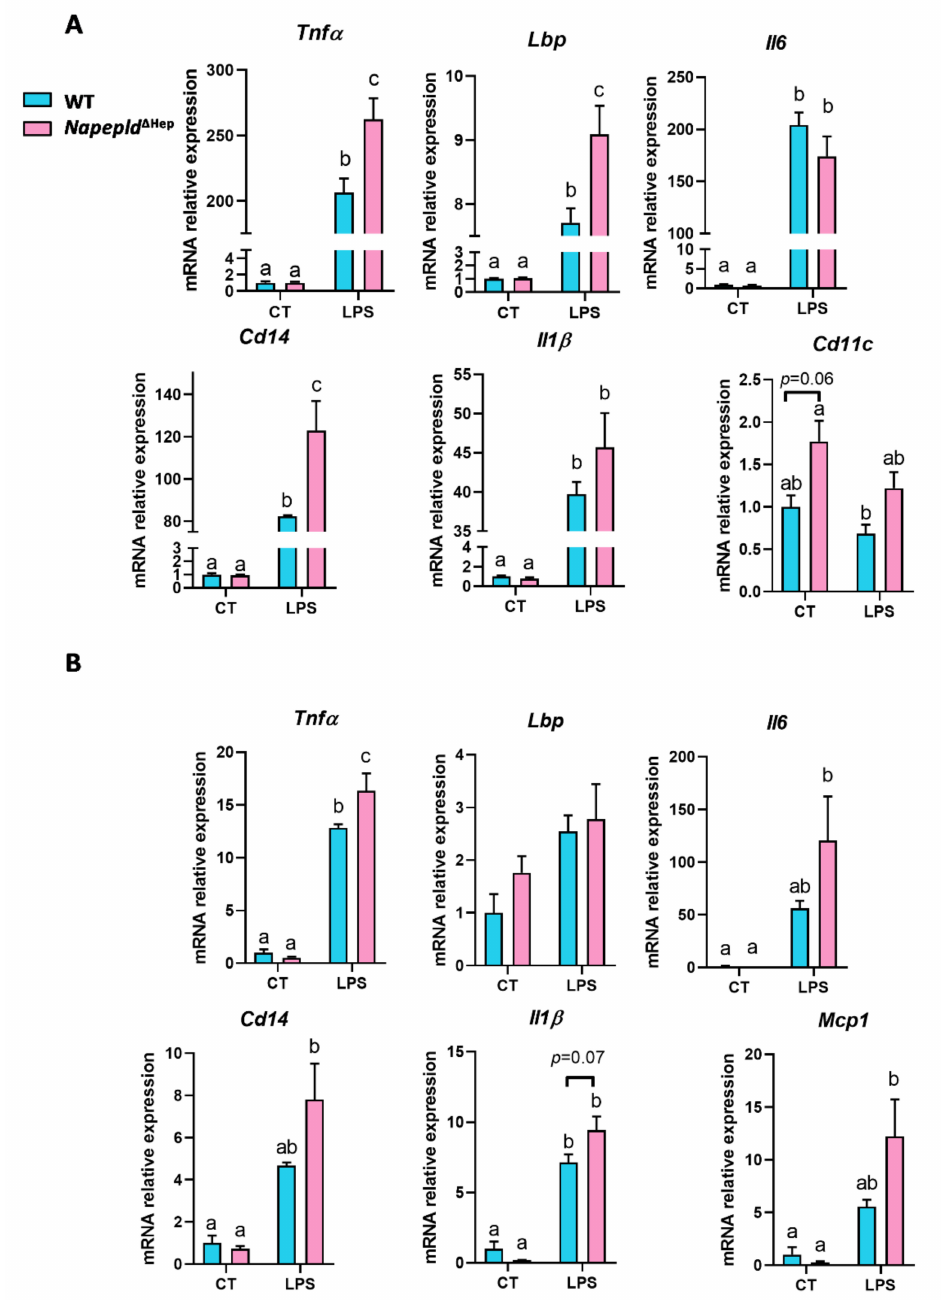
Figure 6. Napepld ∆ Hep mice are more sensitive to inflammation. mRNA expression of inflammatory markers measured by real-time qPCR in WT and Napepld ∆ Hep mice injected with either saline solution (control (CT)) or LPS ( A ) in the liver and ( B ) in the subcutaneous adipose tissue (SAT). Blue: WT ND mice. Pink: Napepld ∆ Hep ND mice. Data are presented as the mean ± s.e.m. ( n = 4–6). Data with di ff erent superscript letters are significantly di ff erent ( p < 0.05) according to a two-way ANOVA followed by a Tukey post hoc